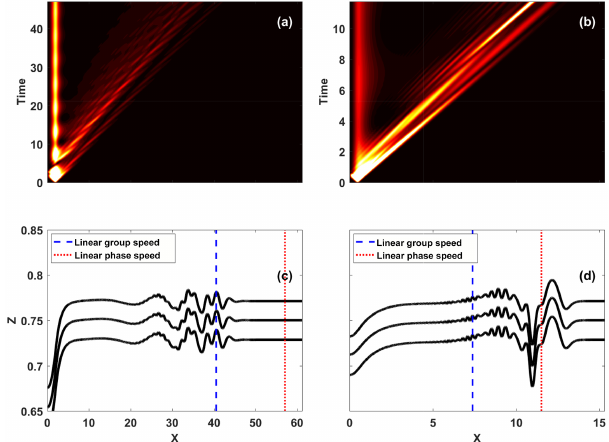
Figure 3. Panels (a) and (b) show a space–time plot of vertically integrated kinetic energy, while panels (c) and (d) show three den- sity isolines at t = 47 . 25 and t = 11 . 81 respectively. Panels (a) and (c) correspond to the Ro = 0 . 5, f = f 0 , and w = w 0 case, and pan- f 0 , and w = w 0 case. The verti- els (b) and (d) to the Ro = 2, f = 1 4 cal lines in panels (c) and (d) represent the distance the waves would have travelled according to the linear phase and group